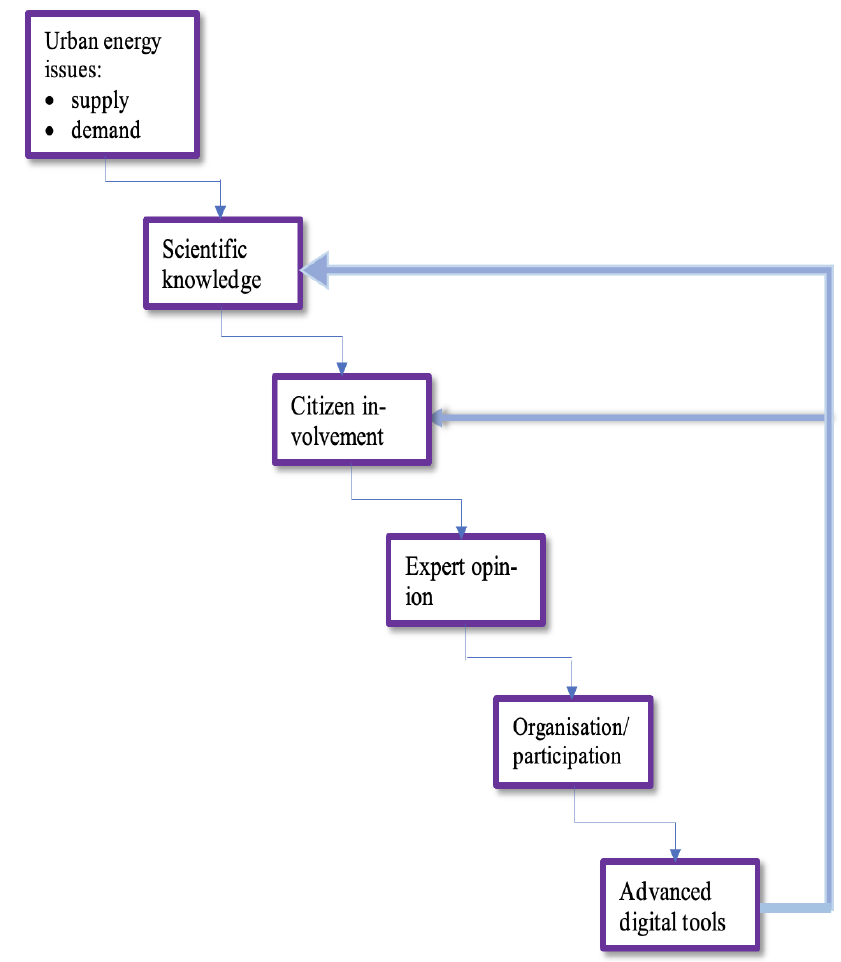
Figure 6. Participatory digital energy transition support systems.